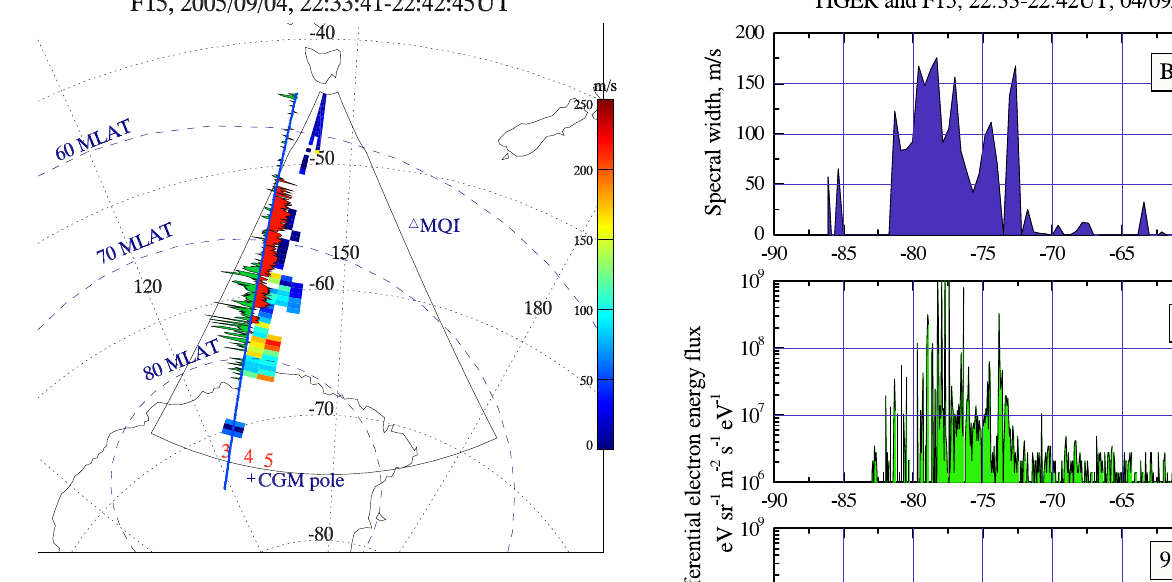
Fig. 11. Overpass of DMSP15 over TIGER filed of view on 4 September 2005. sampled at 1 s rate. The respective time series are shown in Fig. 12 emphasizing the coincidence between the increase in W and intensification of the low-energy electron precipita- tion, while the high-energy electrons show no obvious effect on the spectral width.